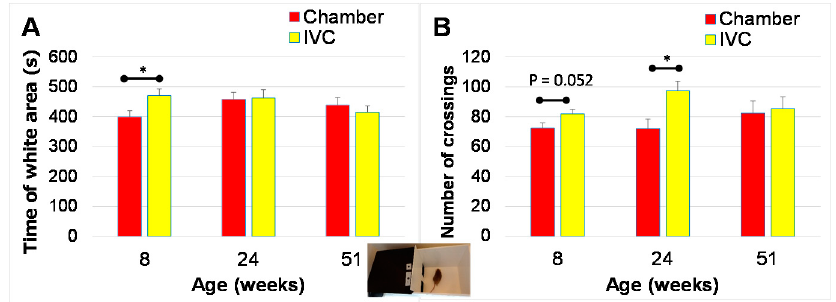
Figure 8. Changes in behaviors with aging in black and white box test in the chamber and IVC groups (Test 6): ( A ) Time spent in the white area for 900 s; ( B ) Number of crossings between the white and black areas for 900 s. * p < 0.05 by t-test.